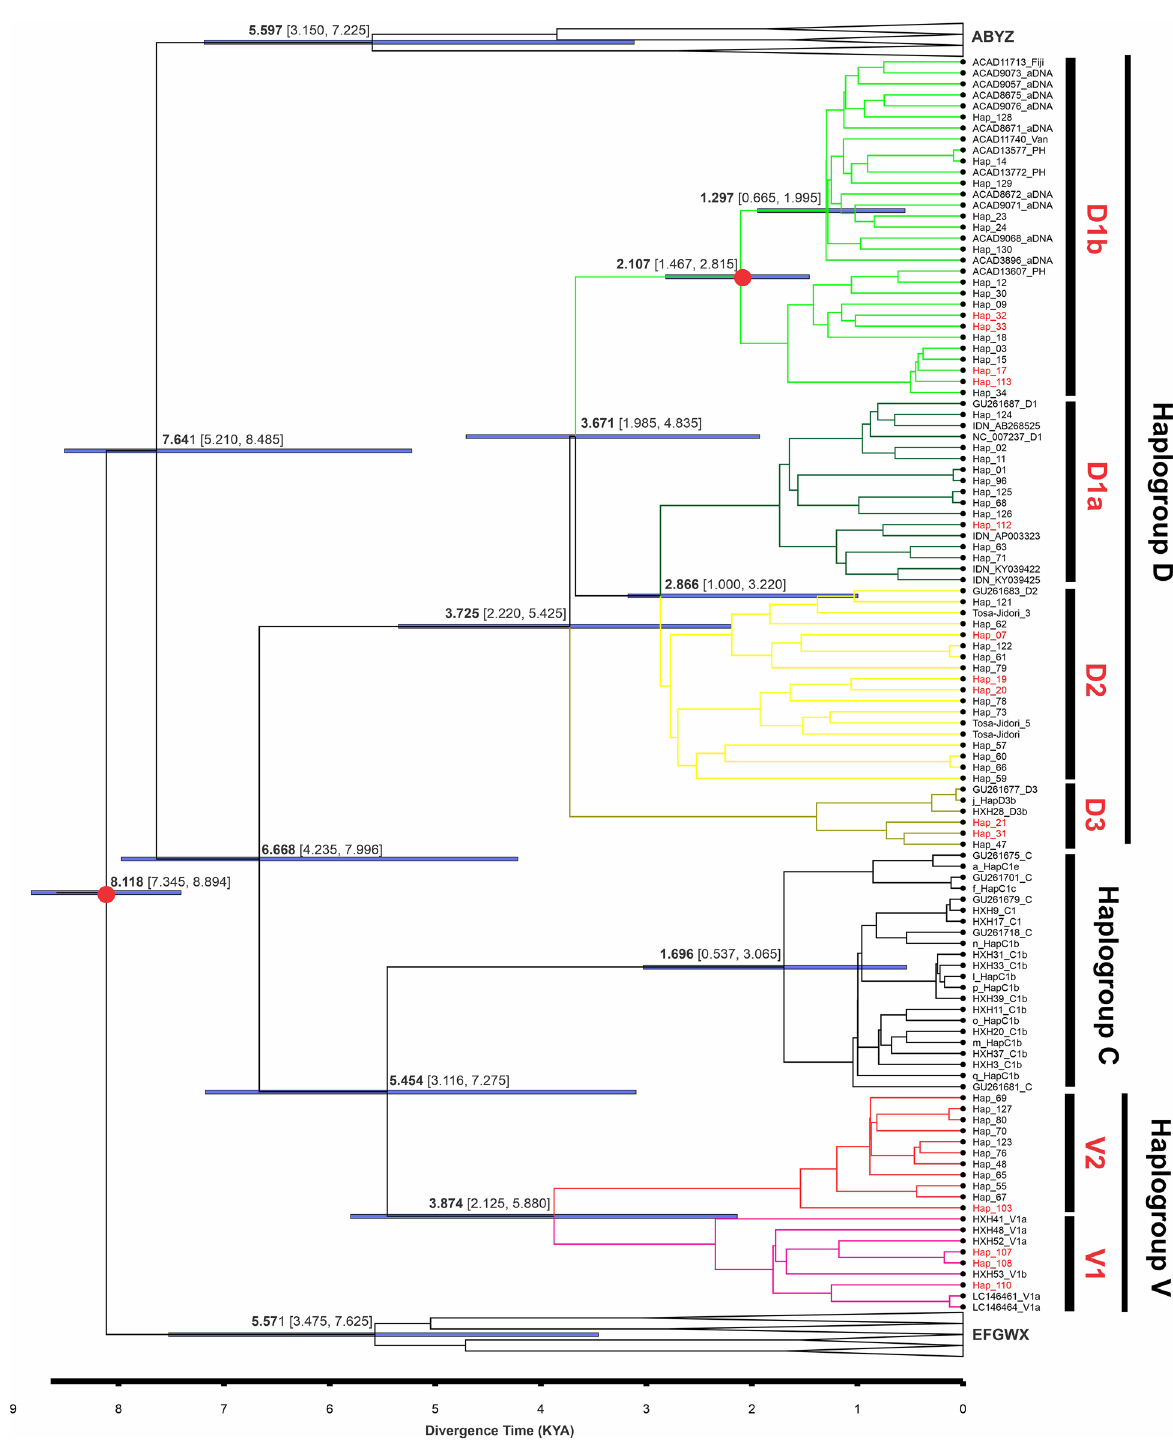
Figure 4. Time tree phylogeny depicting divergence time estimate based on primary and secondary calibration using BEAST2 v2.6.6. Red dots indicate the nodes with calibrations. Node labels indicate the median estimated divergence time, blue bars indicate the 95% HPDs. Tip labels highlighted in red indicate red junglefowl. Tree file was visualized and edited in FigTree v1.4.4. (http:// tree. bio. ed. ac. uk/ softw are/ figtr